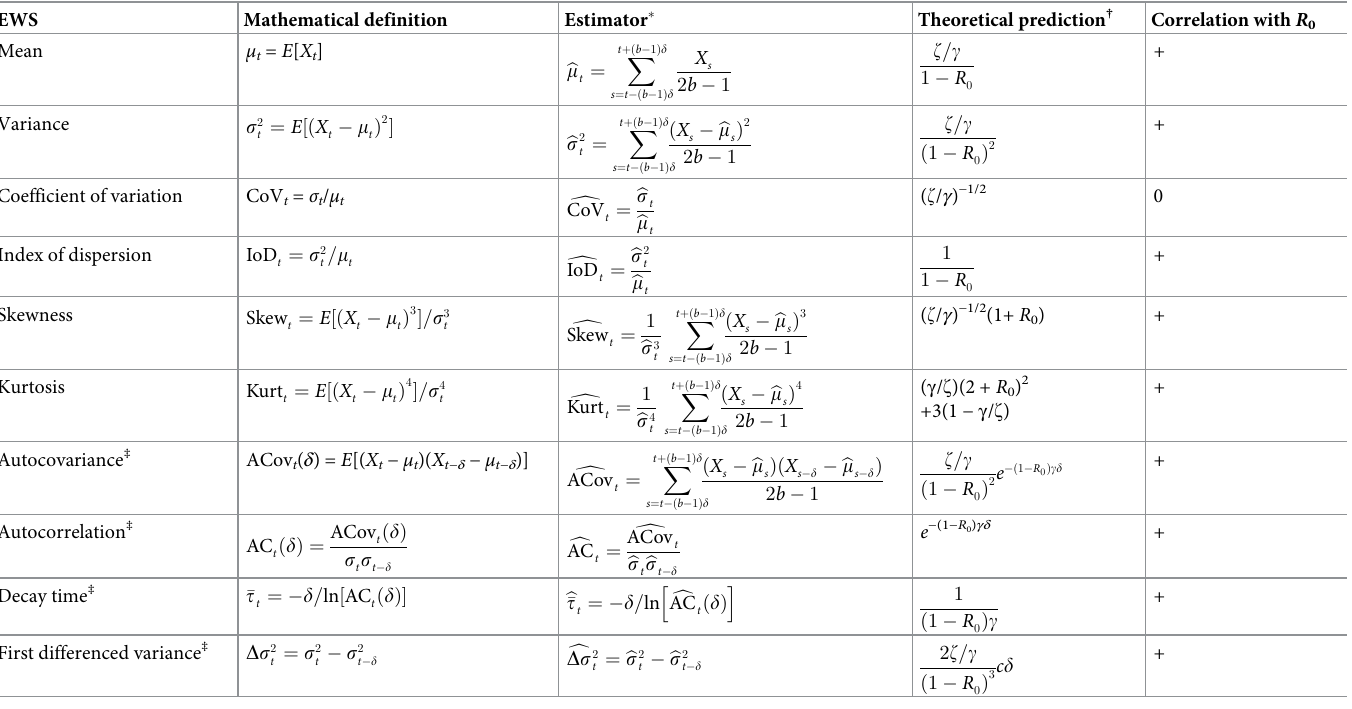
Table 3. List of early-warning